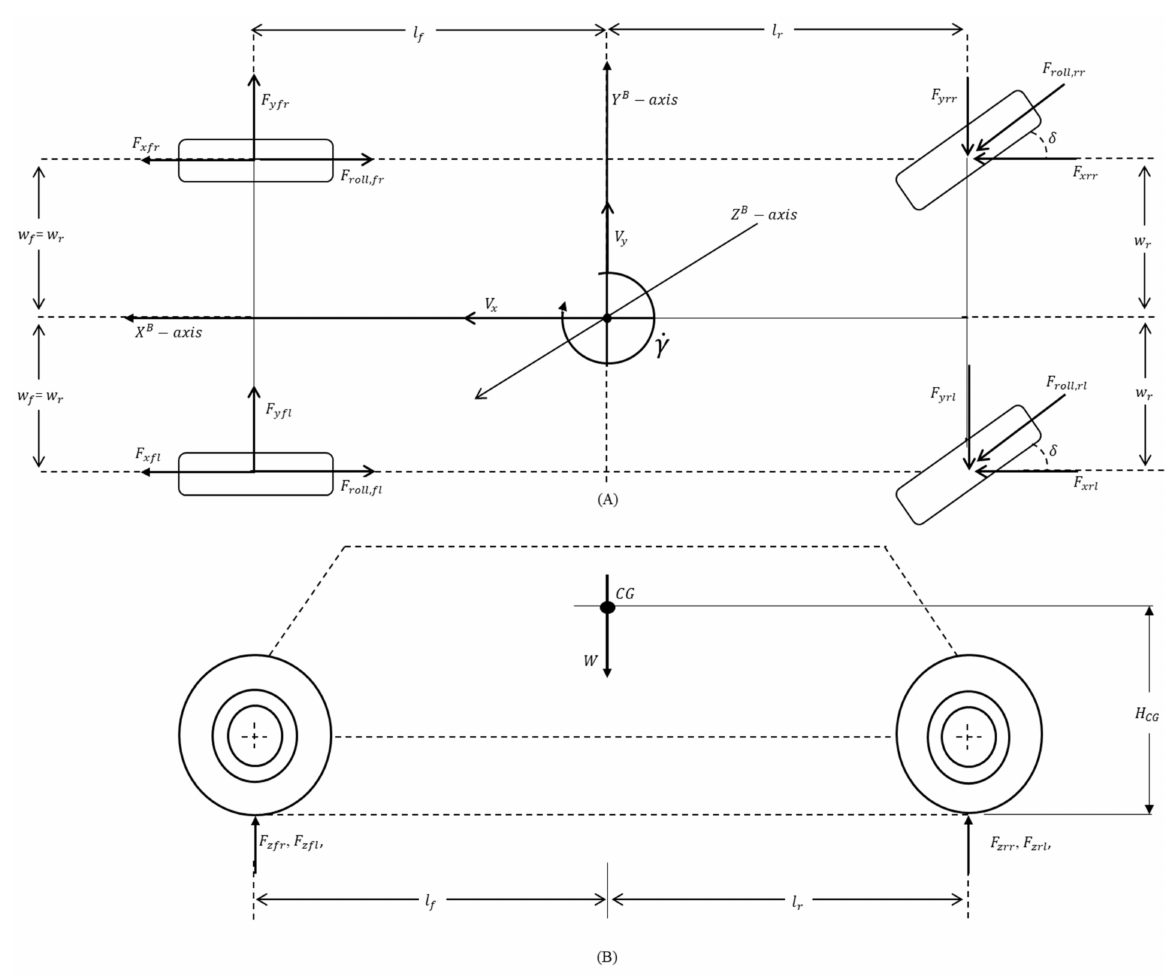
Figure 1. Free body diagram of the vehicle: ( A ) view from the top and ( B ) view from the side. F xi stands for the longitudinal tire-road friction force for the wheels; F yi stands for the lateral tire-road friction force for the wheels; F roll , i stands for the rolling resistance force on wheels direction of travel; the subscript, i , in F xi , F yi , and F roll , i stands for f l , fr , rl , and rr , respectively, with f l , as front left; fr , front right; rl , rear left, and rr , rear right, respectively. l f stands for distance from the vehicle center of gravity to axis that passed through the center of the front wheels; l r , distance from the vehicle center of gravity to the axis that passed through the center of the rear wheels; W f and W r , front and rear wheelbase (equal length); H CG , height of the center of gravity; and CG , the center of gravity. Vertical forces acting on each wheel are defined as follows